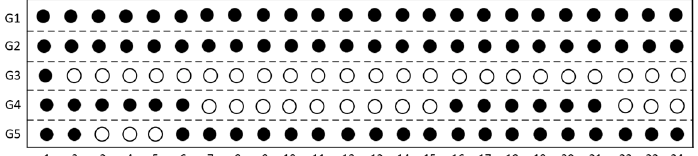
Figure 12. Commitment status of units with 10% penetration of wind power generation.